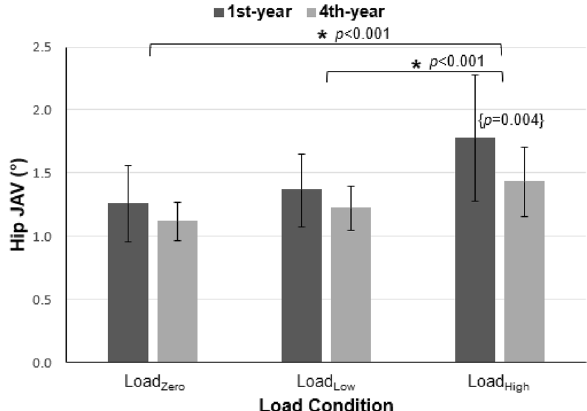
Figure 2. Effects of load and experience level on hip joint angle variability (JAV). Error bars indicate standard deviations. The symbol * indicates a significant paired difference between load conditions, while {} indicates a significant difference between